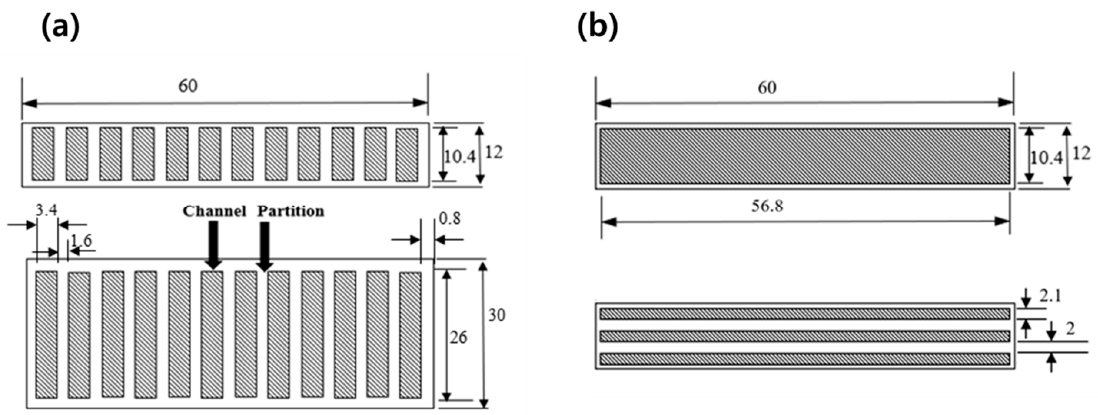
Figure 1. Geometry of the thermoplastic polyurethane (TPU) (unit: mm): ( a ) specimen 1 (12 channels), ( b ) specimen 2 (3 channels).